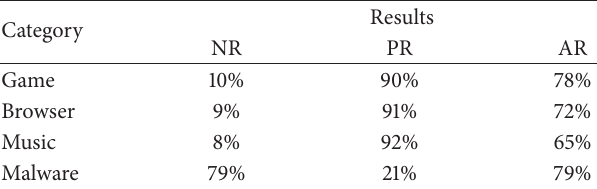
Table 2: Detection rate of statistical.